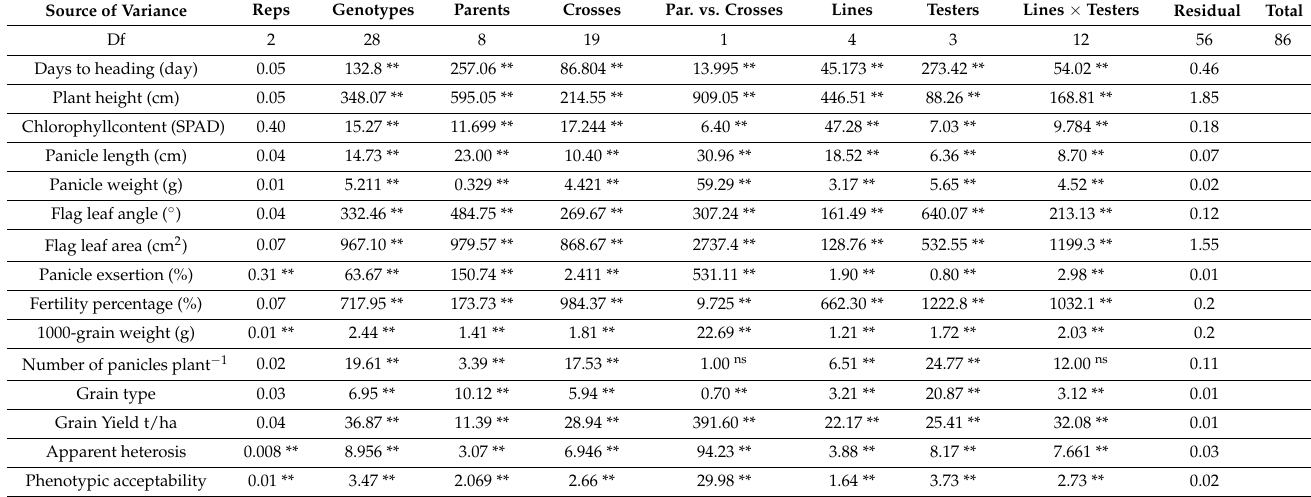
Table 1. Analysis of variance for 15 yield and contributing traits across 29